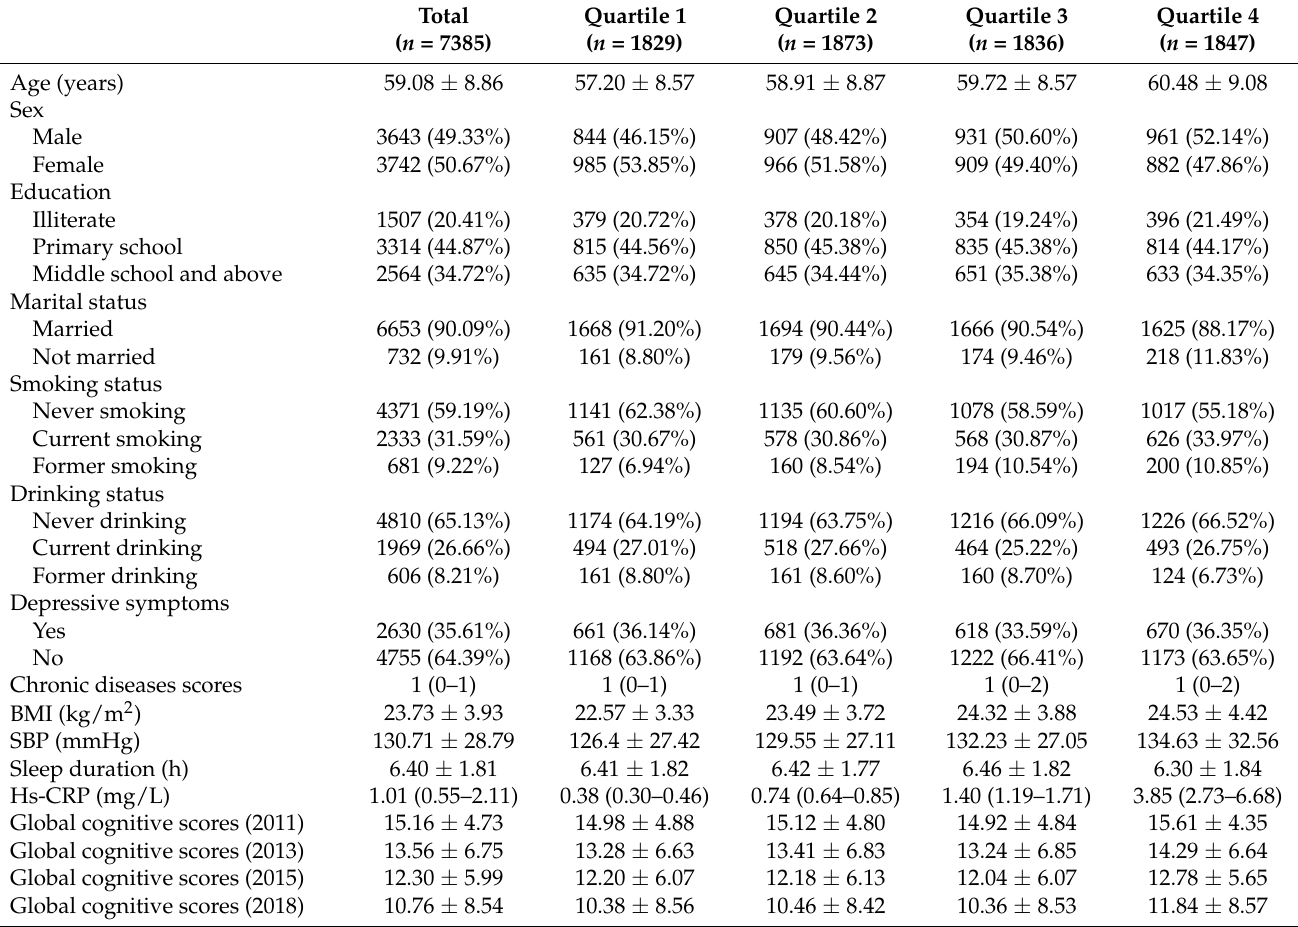
Table 1. Baseline characteristics of study participants according to baseline Hs-CRP level.